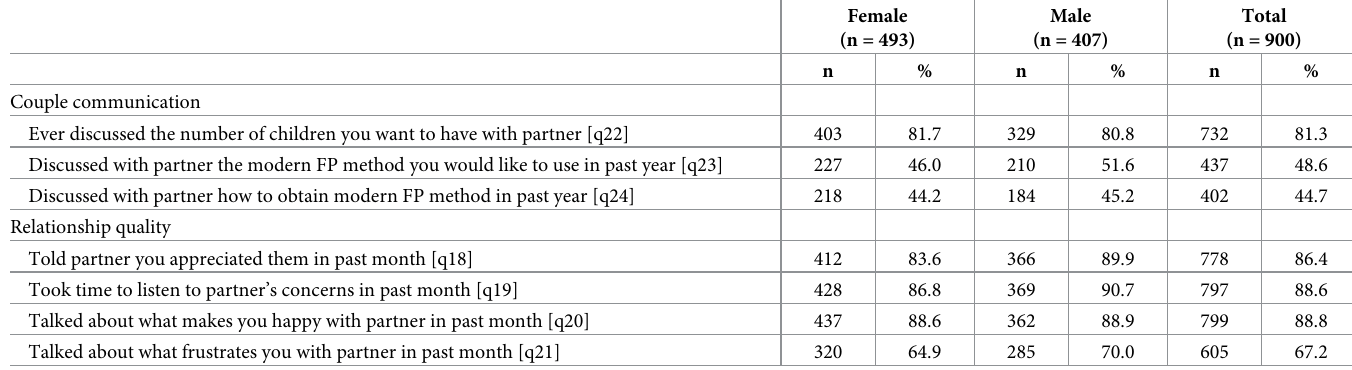
Table 3. Couple communication and relationship quality among male and female survey